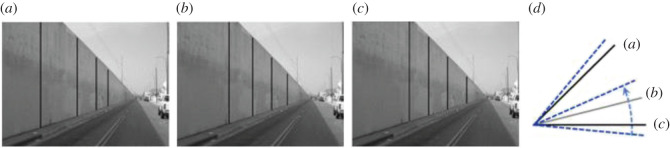
Example of pictorial perspective images with different intervals between the left and right pair of lines. The interval between the middle two lines remains constant across the images. (a) Line separations consistent with equidistance on the depicted surface in 3D scene (derived using a standard method using vanishing points [55]). (b) Line separations that are equidistant for a depicted surface slant that is less than slant depicted in the 3D scene (underestimated slant). (c) Shows lines that are equidistant in the depicted 3D space. (d) Diagrammatic representation of the derivation of the line intervals assuming different slants ranging from slightly less than slant 0 (equidistance on the plane of the picture (c)) to slightly greater than the depicted 3D slant (a). Stimuli were constructed for a total of 32 steps.